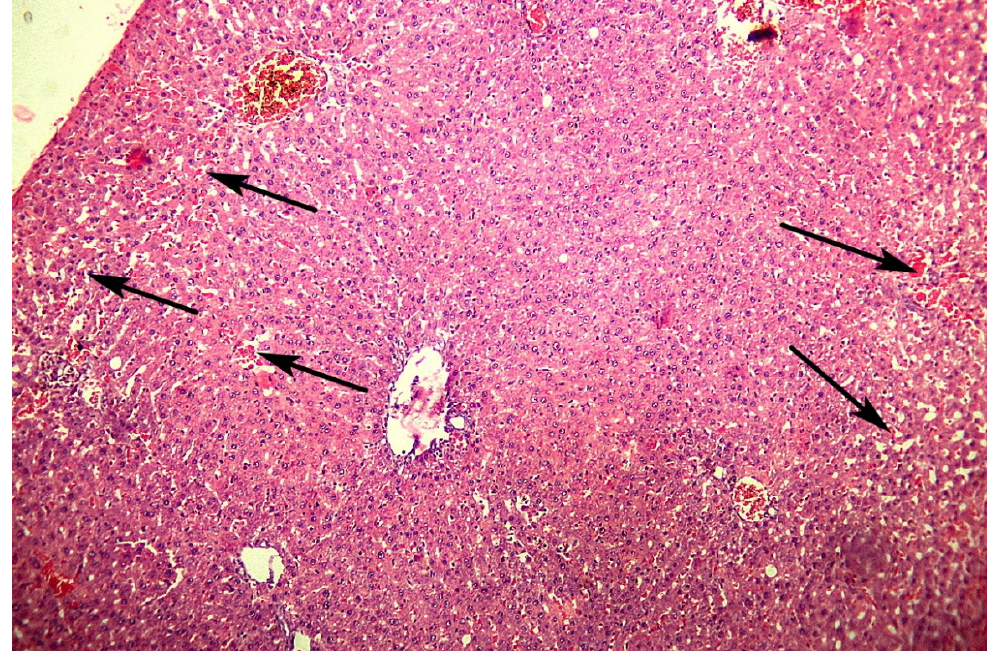
Figure 3. Photomicrograph of the liver. Adult rats, 3rd day after mTBI. Numerous dilated sinusoidal capillaries all over the visual field with blood stasis and RBC sludges having occurred. H E, × 100. Three days after mild TBI in the liver histology of juvenile rats, a large number of hepatocytes with dystrophy were revealed. The cytoplasm of such cells is enlightened, irregularly stained, or contains no dye at all with medium-sized vacuoles. The localization of such cells is mainly a subcapsular zone and diffusely deep into the parenchyma in the form of small clusters of 50–100 cells (Figure 4). Changes in the microcirculatory bed in this term appear similar to the previous one—blood stasis in the portal veins and sinusoidal capillaries with RBC sludges and their aggregation to the vessel walls. However, the sinusoidal capillaries’ diameter decreased compared to the previous term and with the control group value and reached 2.38 µ